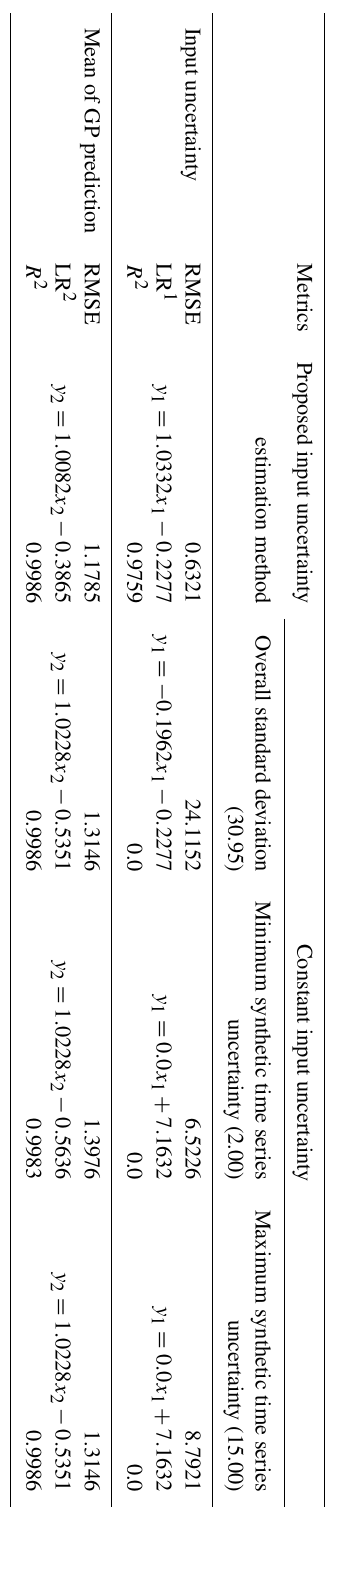
cept for HI02). At HI02, the average ratio between GP means and standard deviations is lower than the threshold (i.e.,